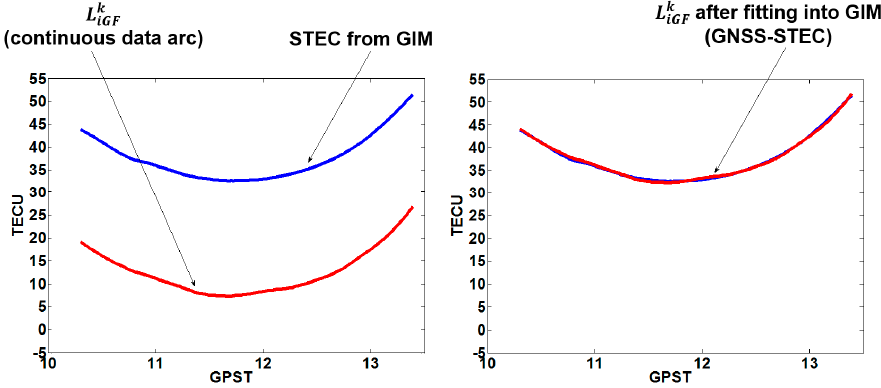
Figure 1. Scheme of 𝐿 (cid:3036)(cid:3008)(cid:3007)(cid:3038) fitting into STEC from GIM for GNSS-STEC analysis [21].